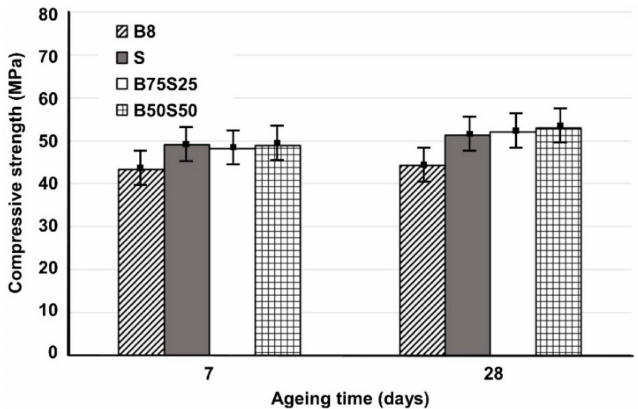
Figure 3. Compressive strength of B8, S (slag), B75S25 and B50S50 IPs produced under the optimum conditions (H 2 O / Na 2 O = 18.2, curing at 90 ◦ C) as a function of ageing time (error bars represent the standard deviation of three